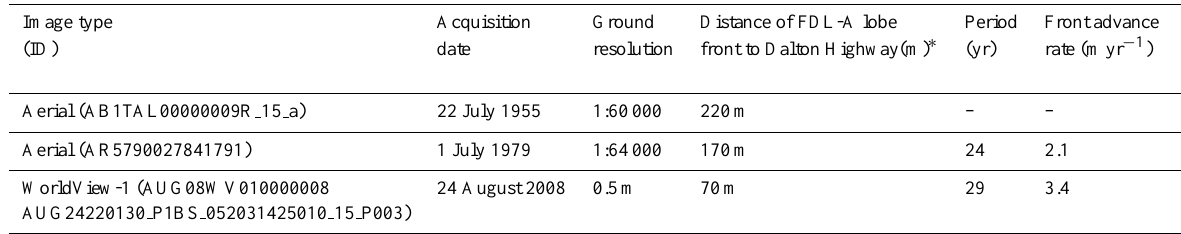
Fig. 4. Schematic overview of some observed processes on a frozen debris-lobe. (A1) Photograph of a frozen debris-lobe with upper zone of solifluction lobes, image shows FDL across the valley from FDL-A; (A2) shear zones in the middle section of FDL-A; (A3) “drunken” trees visible on FDL-A; (A4) split tree trunk on FDL-A; (B) profile of frozen debris-lobe front and associated movement; the flow vectors are assumed and parallel to the flow direction; background elevation model of FDL-A with upper contributing zone based on multiple DGPS surveys. Table 1. Remote-sensing data used for mapping frozen debris-lobes. Image